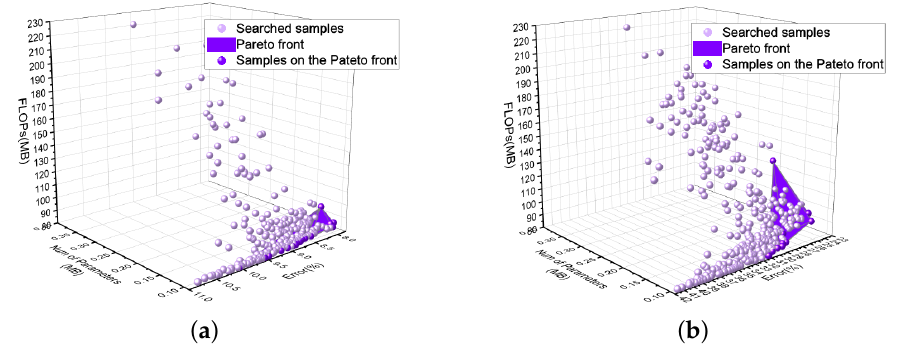
Figure 4. Pareto fronts output in the experiment process.( a ) Pareto front on OPPORTUNITY. ( b ) Pareto front on UniMiB-SHAR.